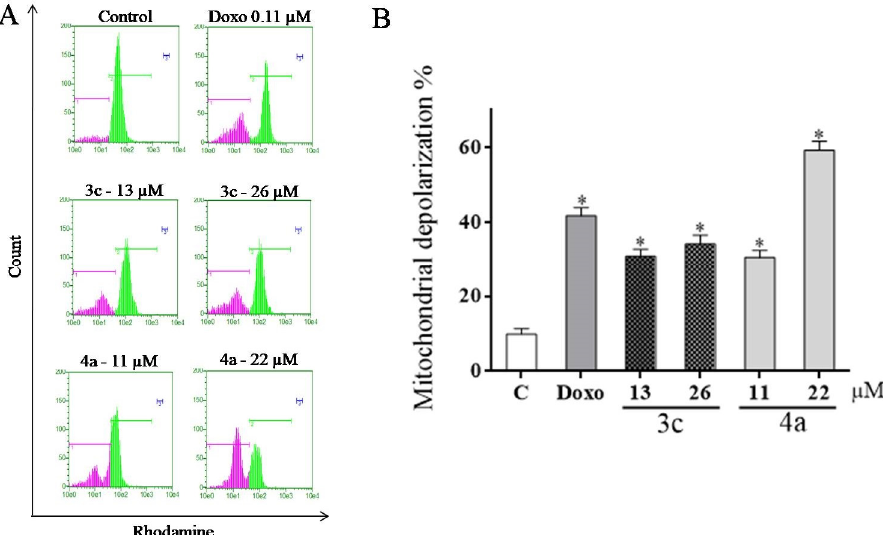
Figure 5. Effect of compounds 3c and 4a on the mitochondrial transmembrane potential ( ΔΨ m) of HL-60 cells after 72 h of incubation. ( A ) Depolarized cells (apoptotic) are stained in purple, while non-depolarized cells (non-apoptotic) are stained in green. ( B ) The percentage of cells with depolarized mitochondrial membrane (apoptotic cells). C = Control, cells were treated with the vehicle (DMSO; 0.1%); Doxorubicin (Doxo, 0.11 µ M) was used as a standard drug. Results are expressed as mean ± SD of at least three different experiments performed in triplicate. * p < 0.05 compared with the negative control by ANOVA followed by Student Newman-Keuls test.